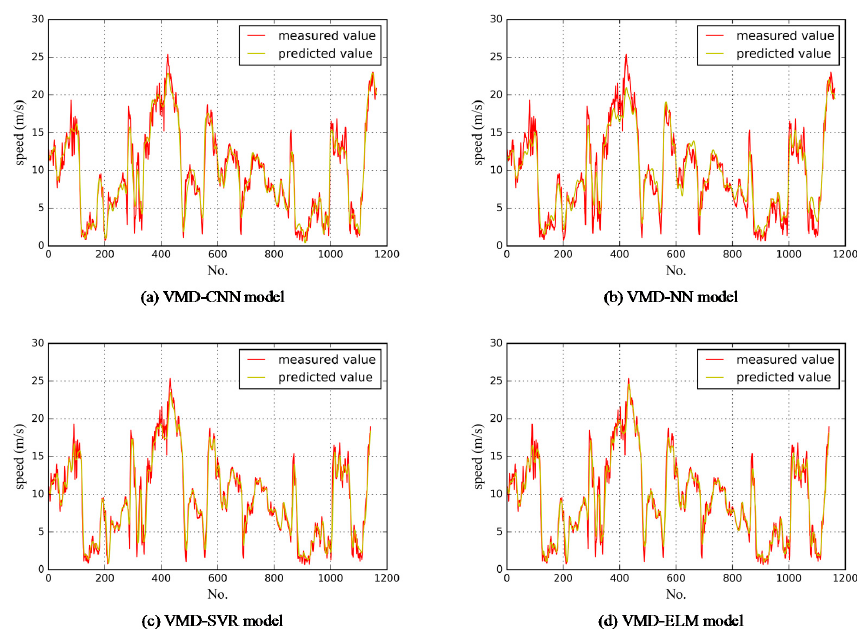
Figure 7. The single-step forecasting results of hybrid methods:( a ) VMD-CNN model, ( b ) VMD-NN model, ( c ) VMD-SVR model, ( d ) VMD-ELM model NN: neural networks; SVR: support vector regression; ELM: extreme learning machine.